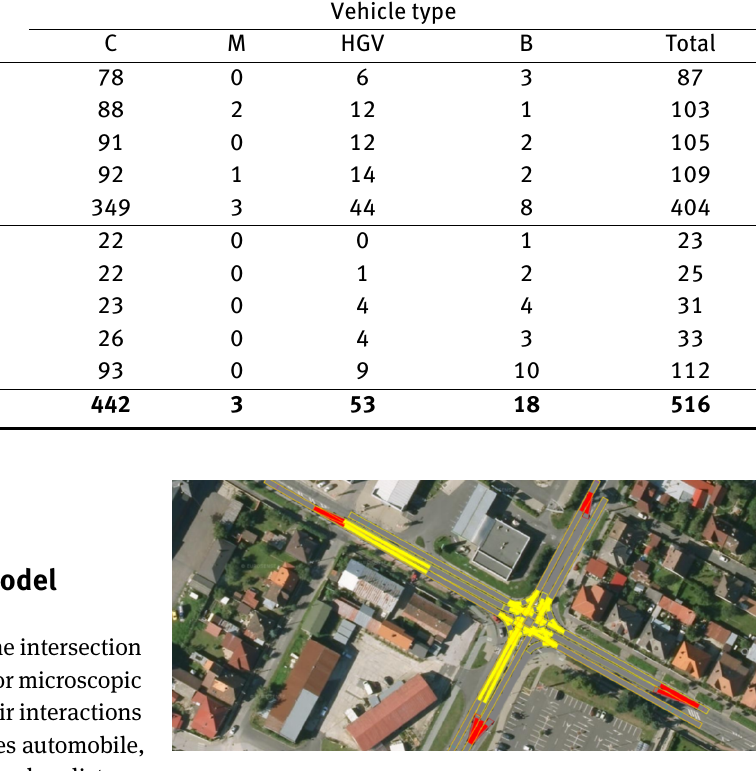
Figure 4: Intersection model - conflict zones visualisation